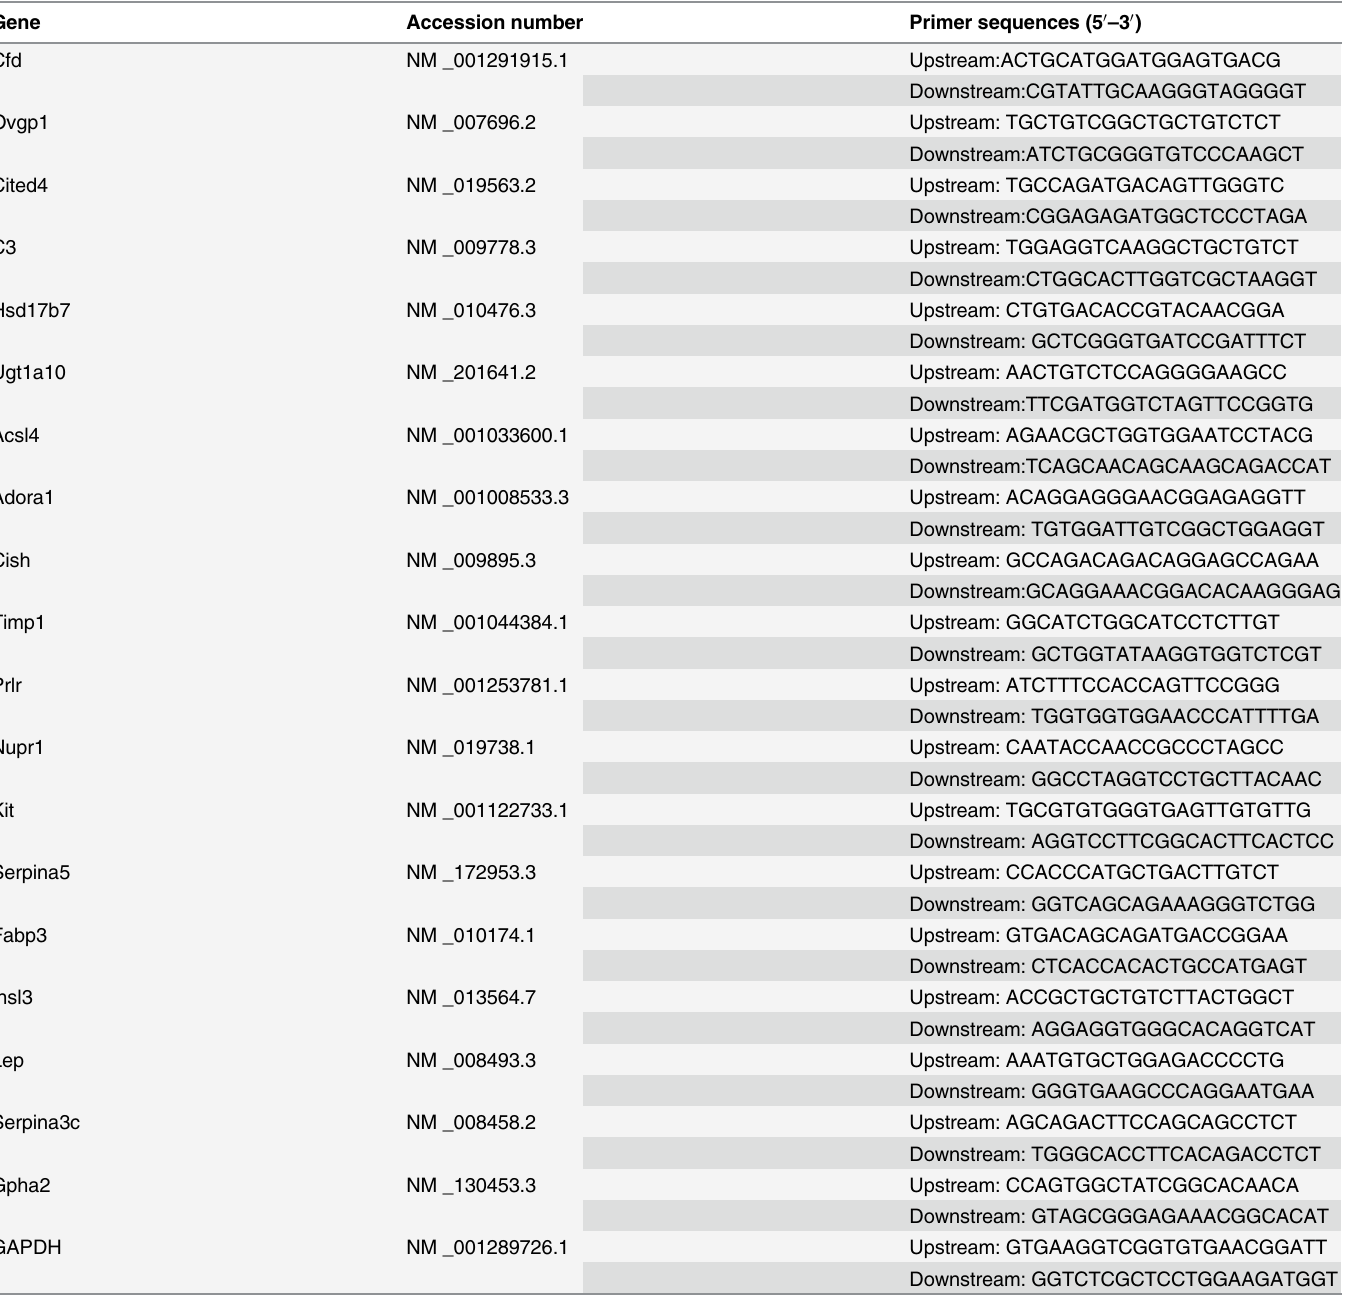
Table 1. Primers used in quantitative real-time